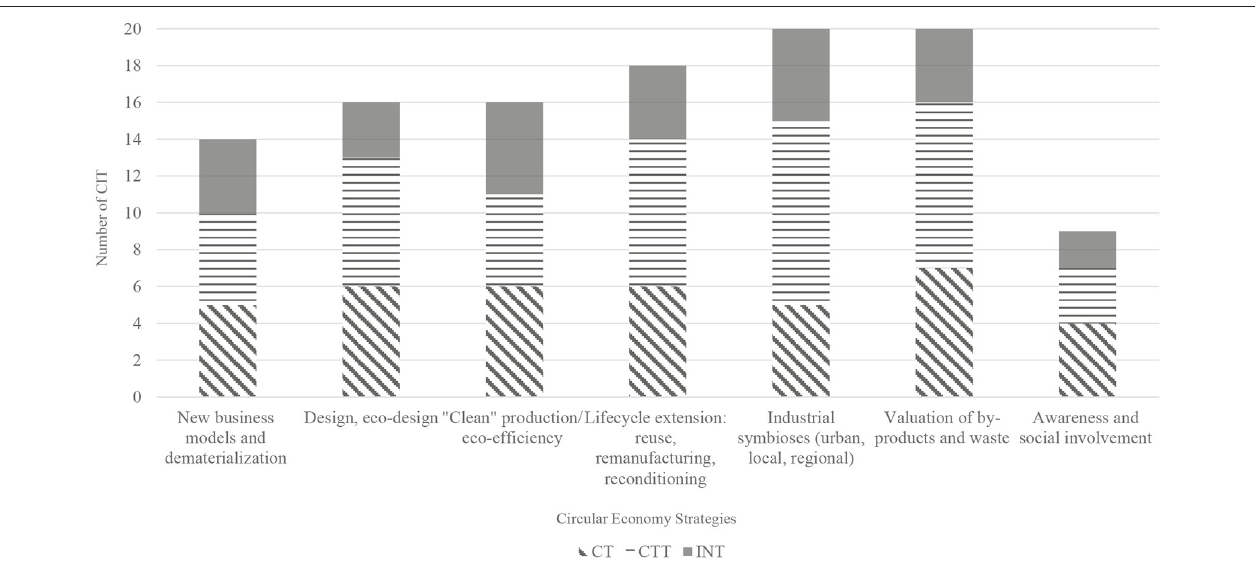
FIGURE 8 | Circular economy strategies in which the future development of skills is